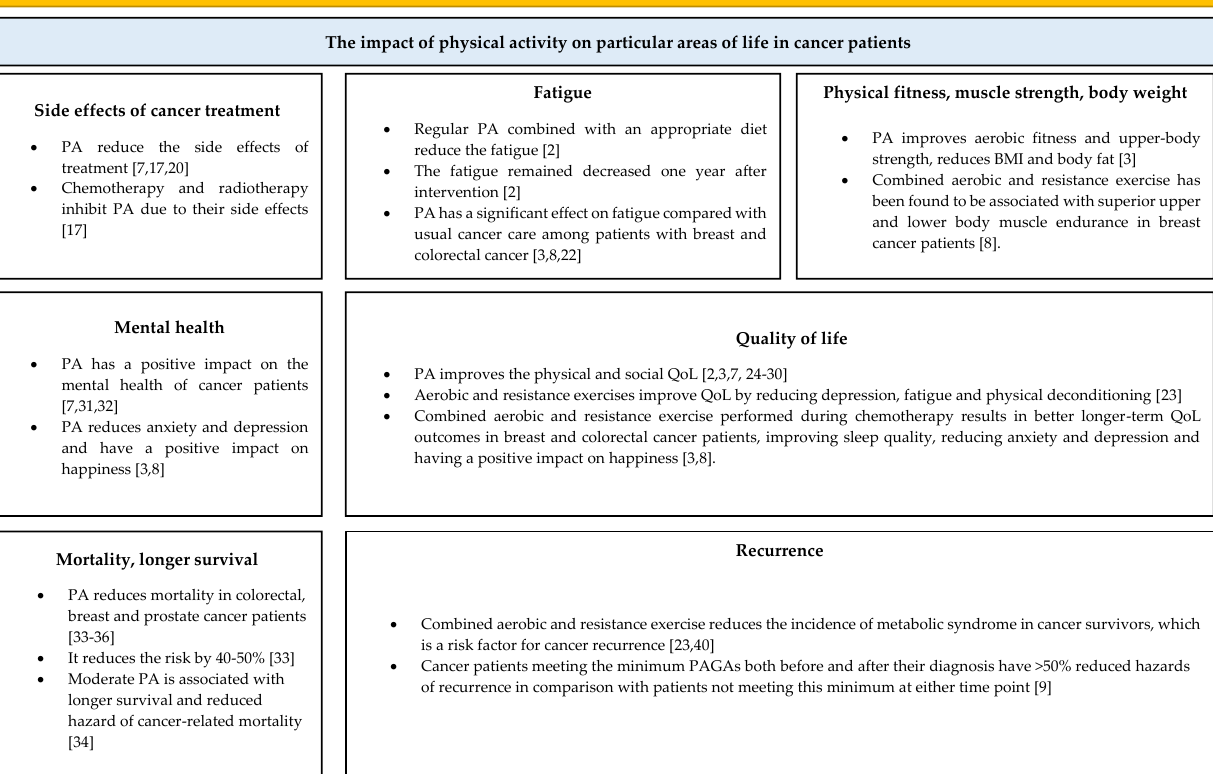
Figure 2. A graphical abstract summarizing the presented results.